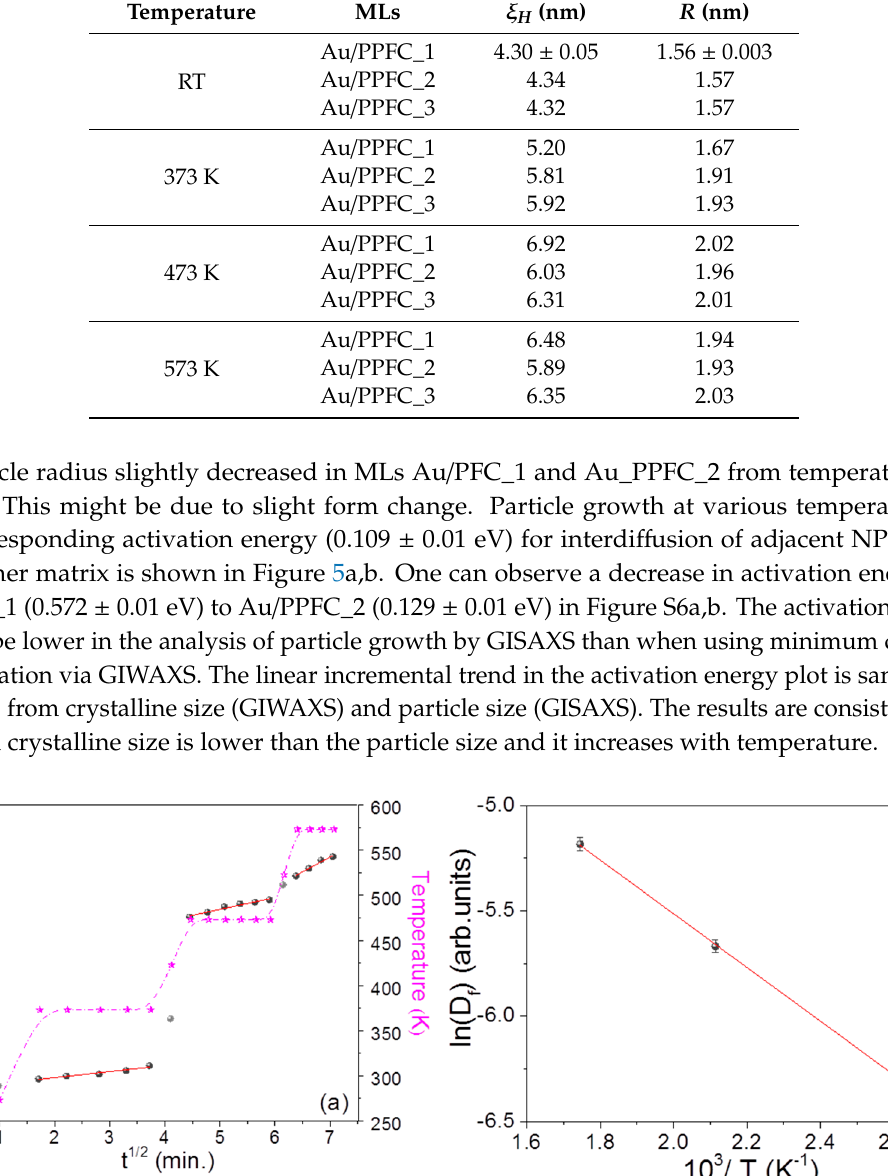
Figure 5. ( a ) Particle size variation in Au/PPFC_3 as a function of annealing time (cid:3435)√𝑡(cid:3439) at varying temperature; the dotted (pink) curve represents the temperature profile of the sample with time and temperature ( b ) Arrhenius plot showing the relationship between ln( D f ) and 10 3 /T for the Au/PPFC_3 ML obtained from in situ temperature-dependent in-plane GISAXS; red line showing linear fit.